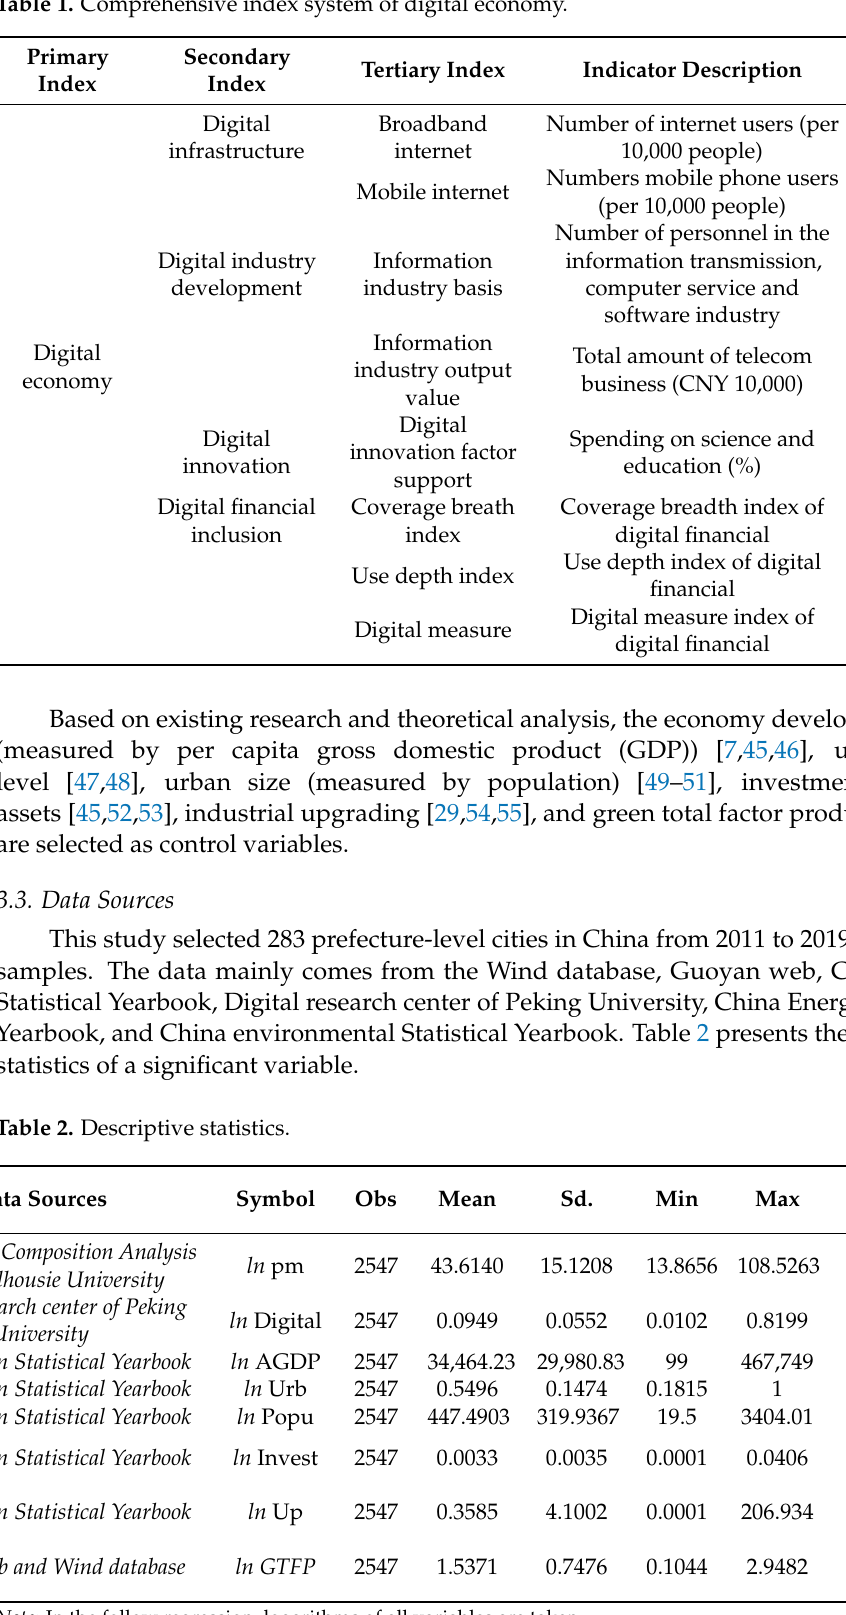
Table 1. Comprehensive index system of digital